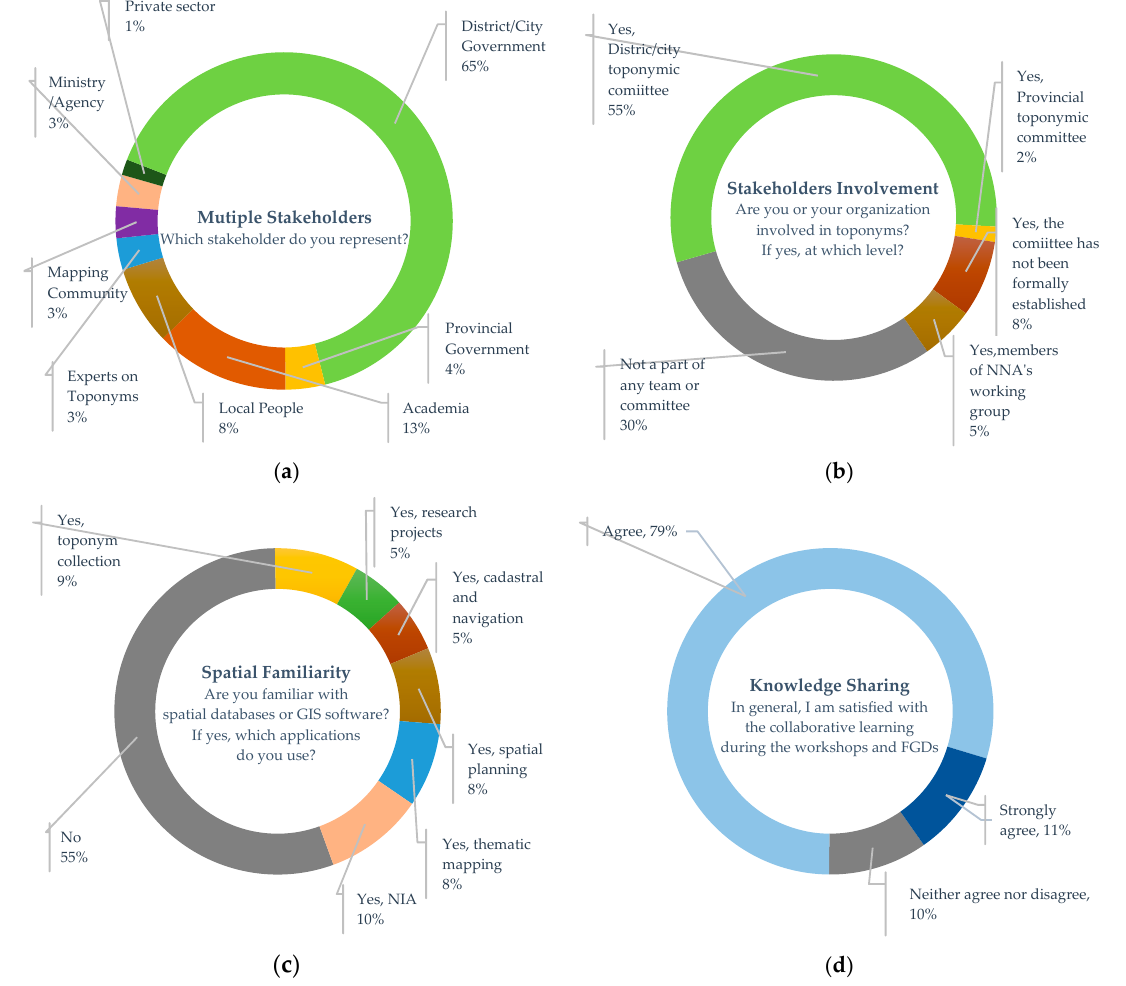
Figure 4. Multiple stakeholders' background and satisfaction on collaborative learning: ( a ) type of multiple stakeholders; ( b ) stakeholders involvement in toponyms; ( c ) stakeholder familiarity with spatial databases or GIS software; ( d ) knowledge sharing